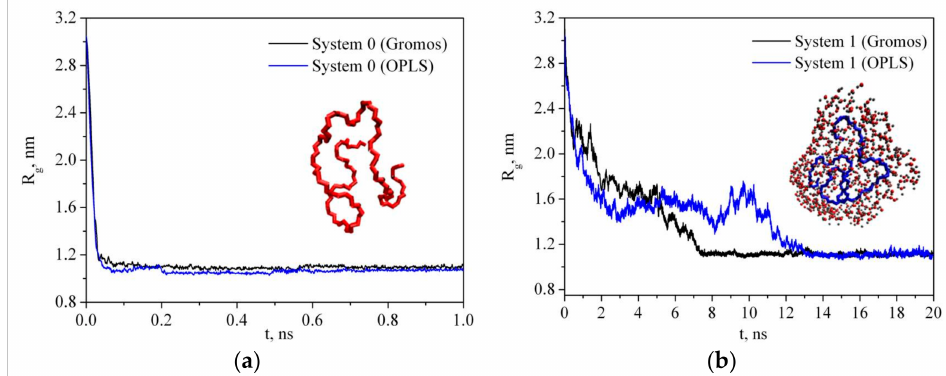
Figure 3. Time dependence of the radius of gyration of PVP in a vacuum ( a ) and in water ( b ).